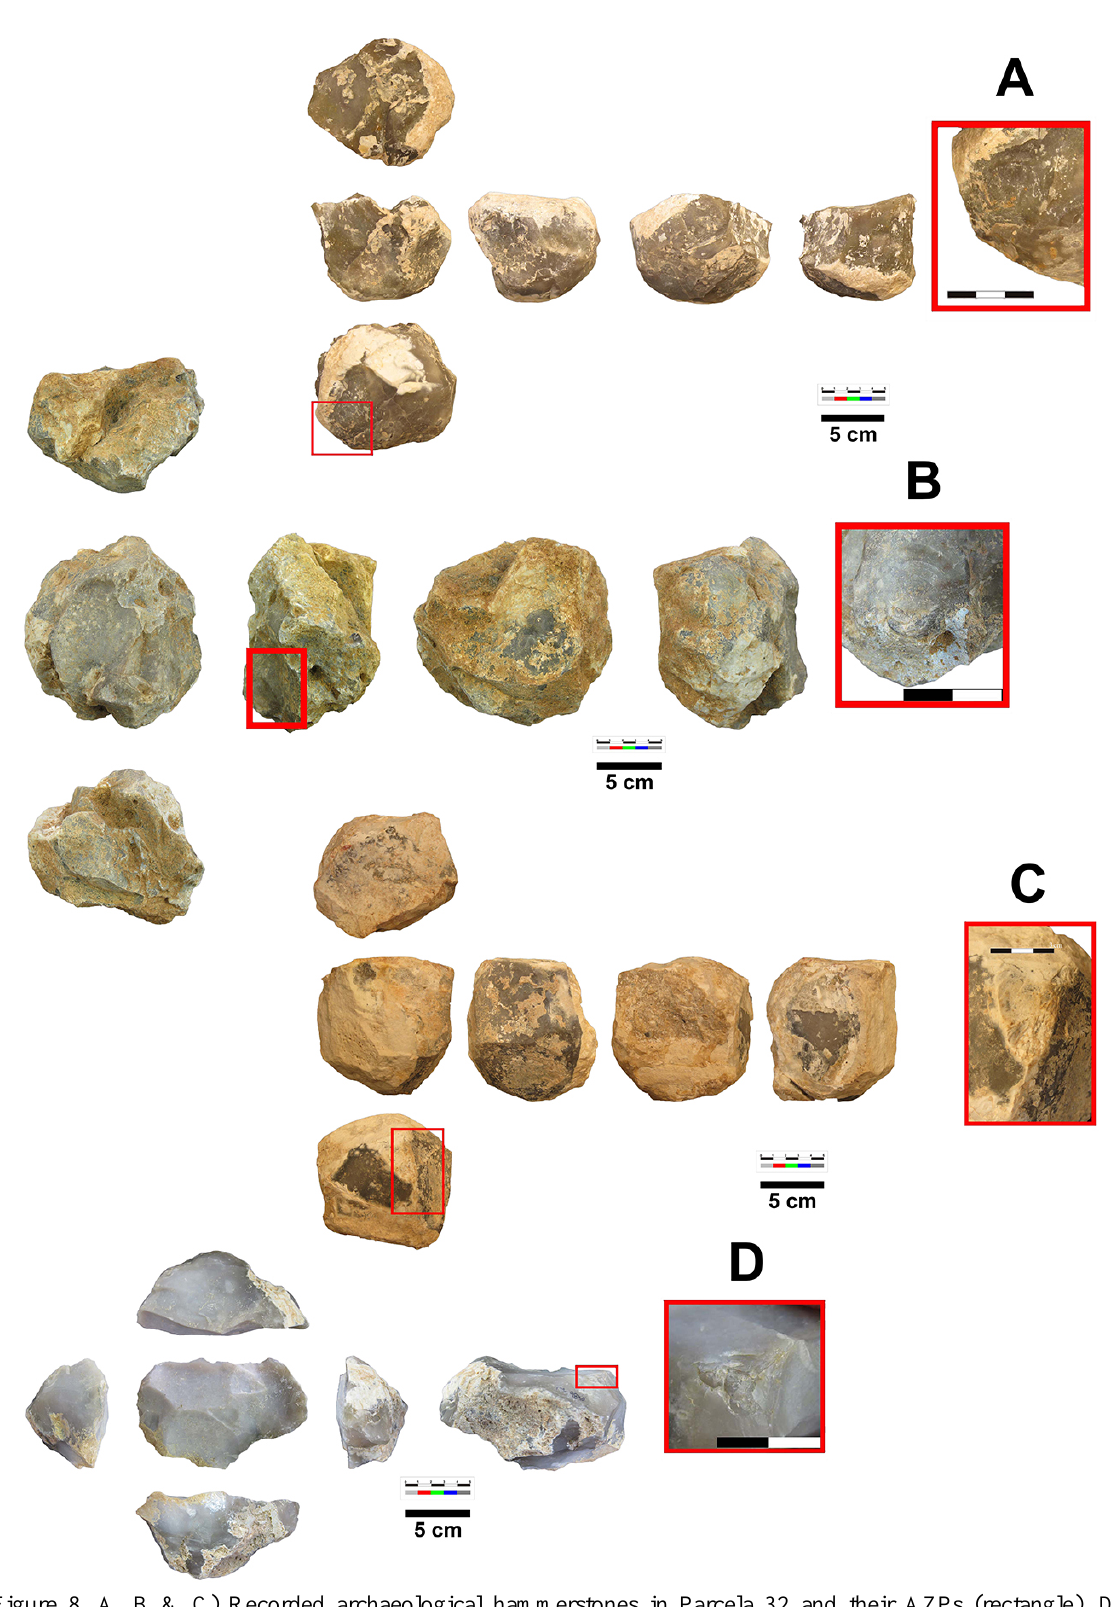
Figure 8. A, B & C) Recorded archaeological hammerstones in Parcela 32 and their AZPs (rectangle). D) Preferential core recycled as a